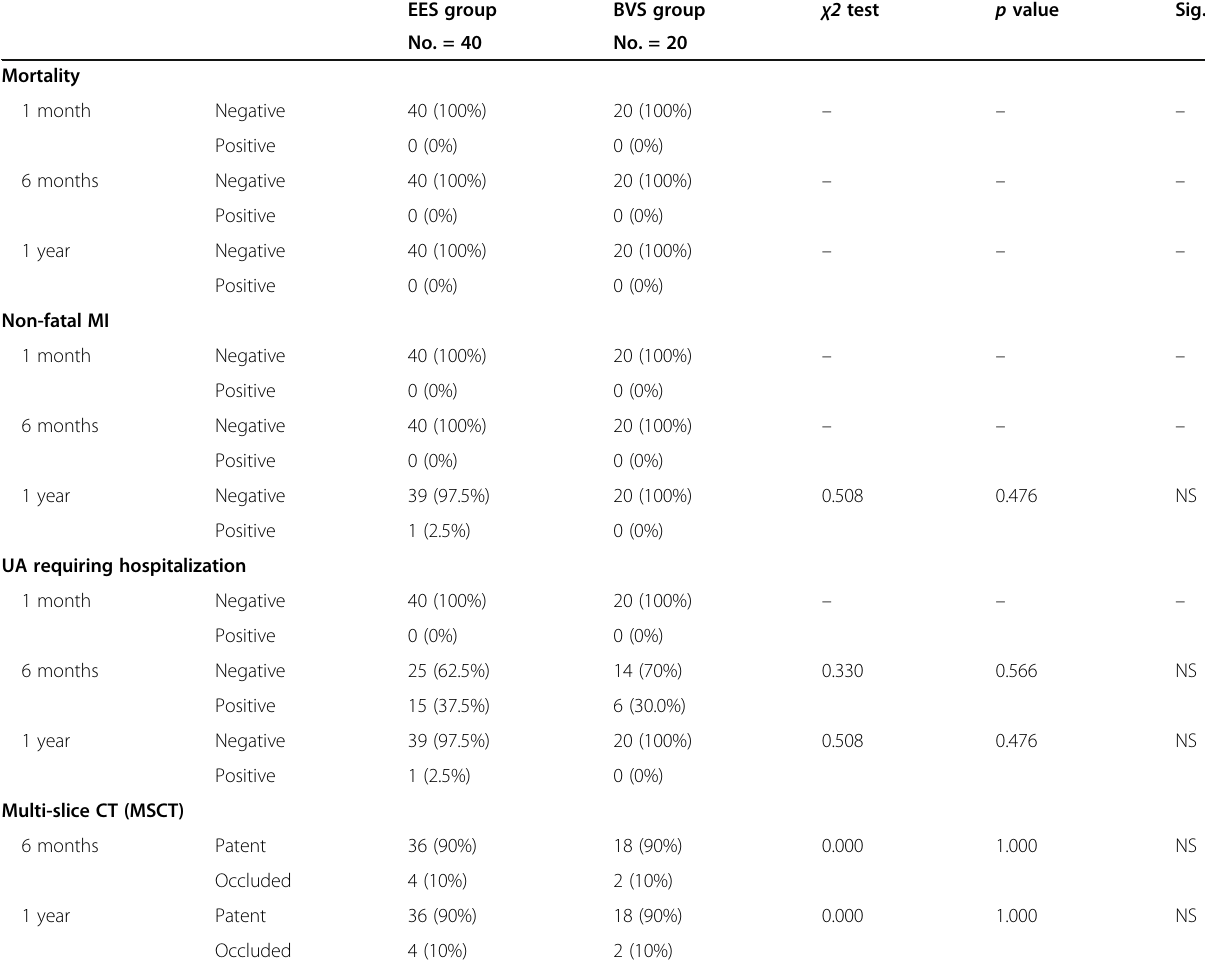
Table 5 Post-procedural follo-up